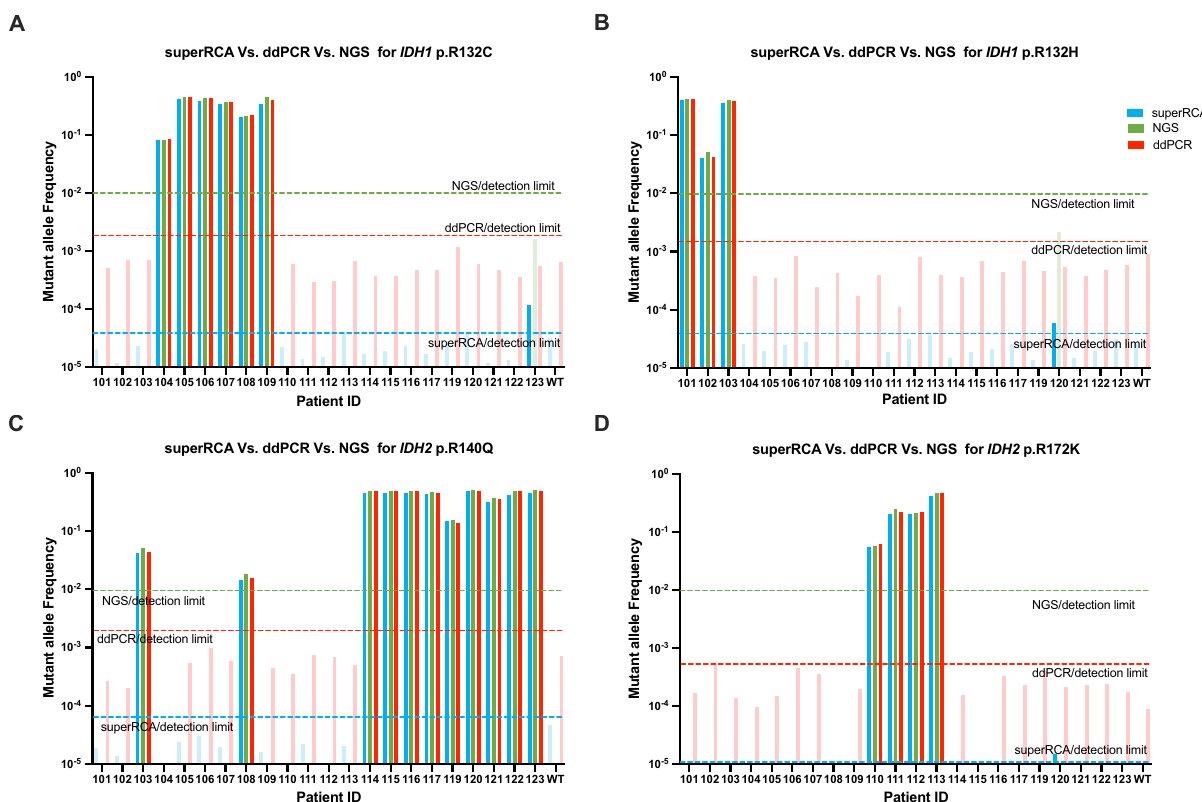
Fig. 5 Benchmarking of superRCA, NGS and ddPCR assays in BM aspirates from AML patients. Samples from 22 patients, all with high proportions of malignant cells in BM, were selected for the benchmark study. 330 ng genomic DNA was used per patient for the multiplexed superRCA assays. After the pre-ampli fi cation step in the superRCA protocol, each sample was subjected to parallel analysis of A IDH1 p.132 C, B IDH1 p.R132H ( C ) IDH2 p.R140Q and D IDH2 p.R172K. For the ddPCR assay, four separate IDH mutation assays were investigated per patient, using 100 ng gDNA divided into two replicates for each mutation. The NGS data were analyzed at diagnosis of the patients, revealing the IDH mutation status for each patient sample included in this benchmark study. Values recorded below the detection thresholds for the ddPCR and superRCA assays are shown in light colored bars. n = 1 biological replicate was analyzed for superRCA, ddPCR and NGS for this panel, and the data were presented as single measurement. Samples for all three analysis methods were collected at diagnosis of the